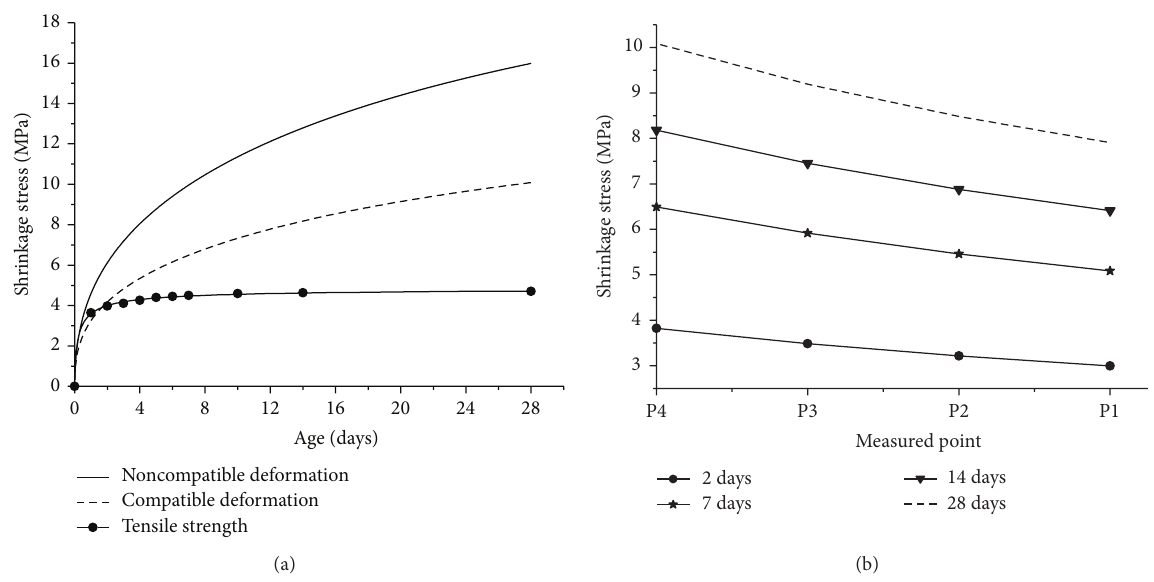
Figure 9: Shrinkage residual stress development with age of mortar. (a) Shrinkage residual stresses at Point 4; (b) shrinkage residual stress